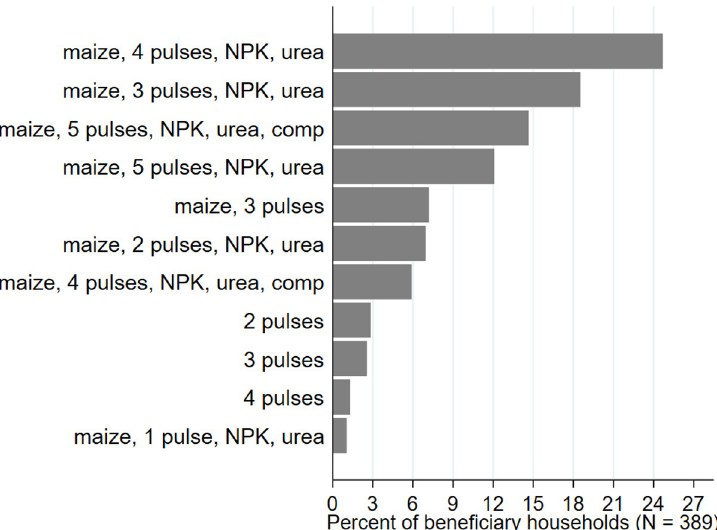
Fig 1. Mix of innovations tested by program beneficiaries. Note: The five pulses include groundnut, pigeon pea, cowpea, soybean, and common bean; NPK : Nitrogen, phosphorous, and potassium; comp : Compost.